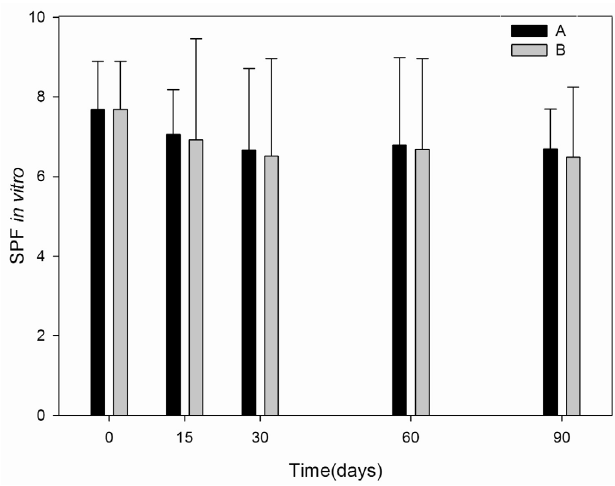
FIGURE 3 - Values of SPF in vitro measured during the stability study. (A): formulations stored at room temperature; (B): formulations stored under accelerated